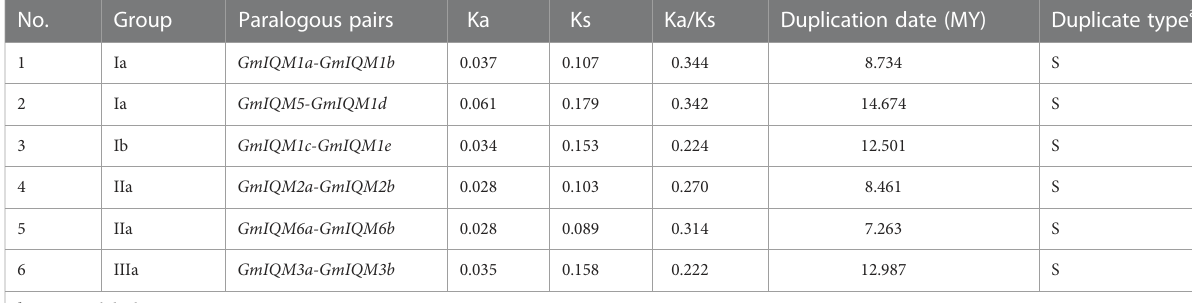
TABLE 2 Divergence between paralogous IQM gene pairs in soybean.